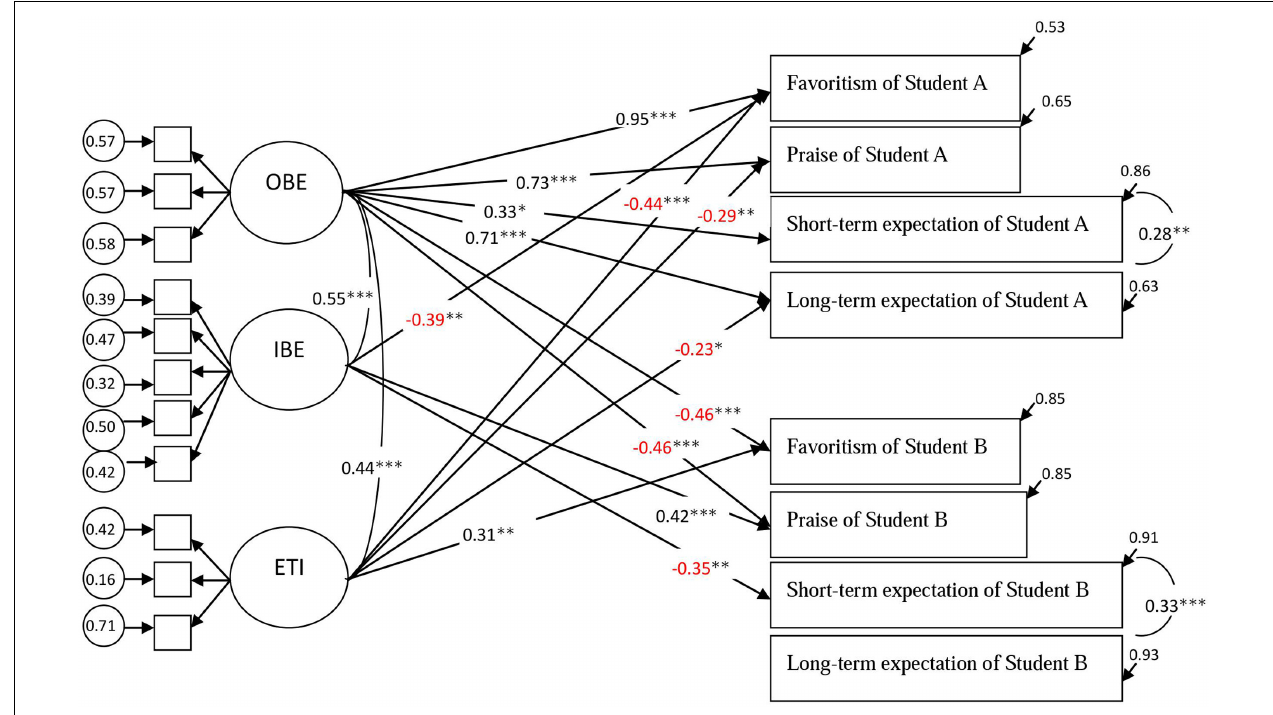
FIGURE 1 | The model of effects of participants’ beliefs about effort and intelligence on attitudes toward Student A and Student B. OBE, obligation-oriented belief of effort; IBE, improvement-oriented belief of effort; ETI, entity theory of intelligence. Only significant paths are included in the figure. Covariates (gender and age) were not included in the figure. Standardized coefficients are reported. Negative effects were colored in red. ∗ p < 0.05. ∗∗ p < 0.01. ∗∗∗ p < 0.001. χ 2 (154) = 302.31, p < 0.001, χ 2 /df = 1.96, CFI = 0.843, TLI = 0.785, RMSEA = 0.08, SRMR = 0.075, gamma hat =